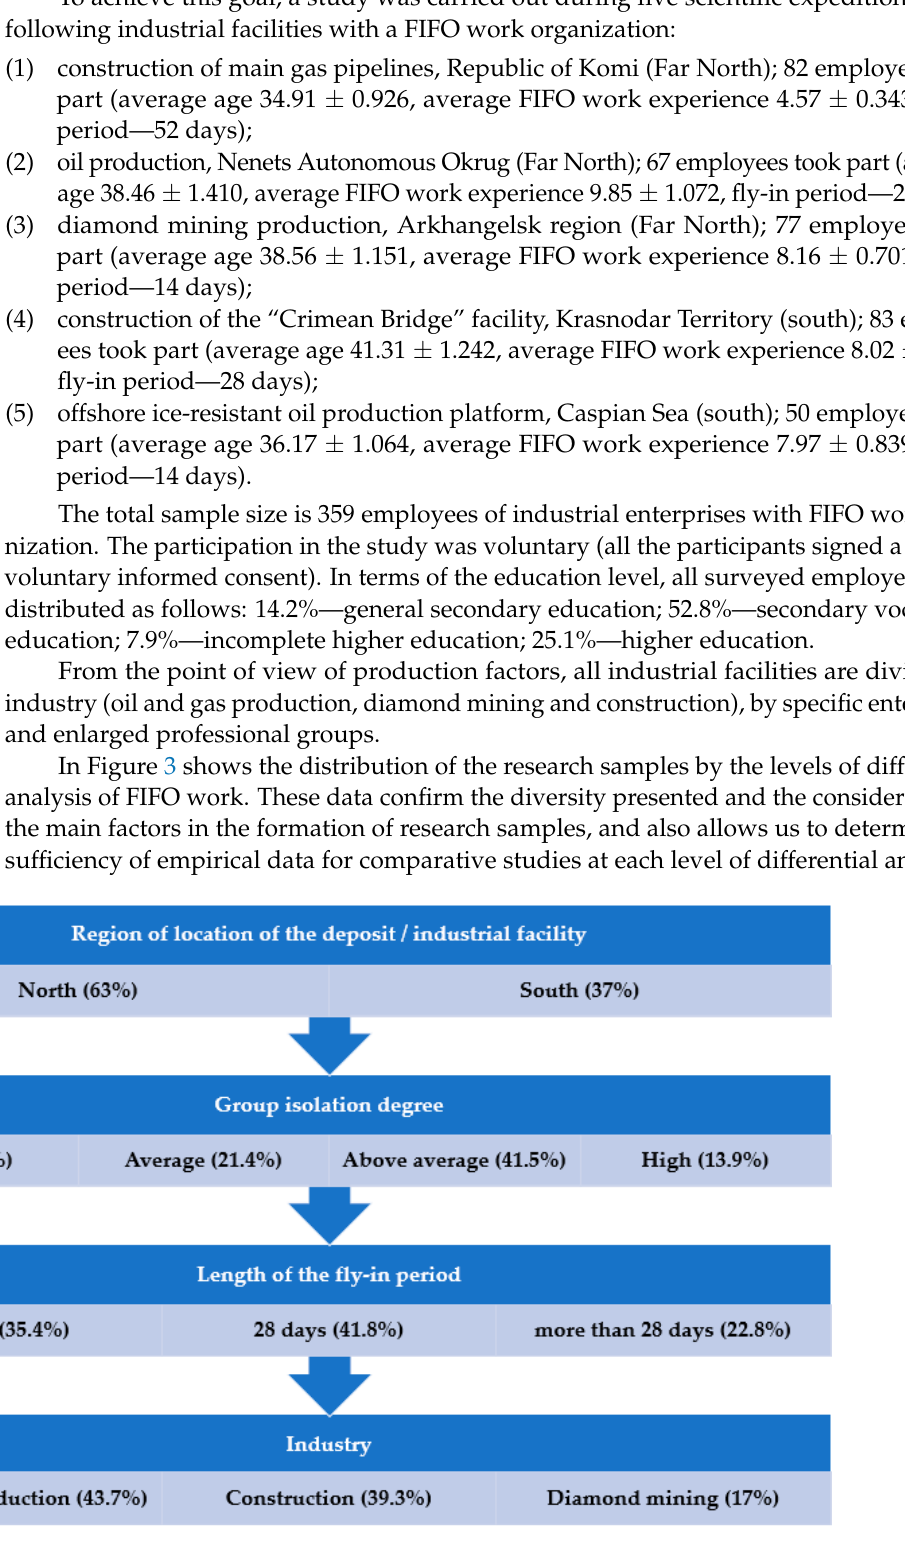
Figure 3. Distribution of research samples by levels of differential analysis of FIFO work. (% of the total research sample). Note: Figure shows how the survey sample is distributed in relation to each of the levels, in parentheses is the% of the sample corresponding to each group.